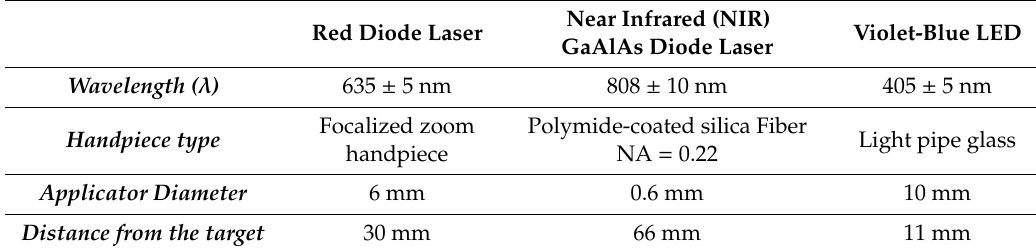
Table 1. Light device specifications.